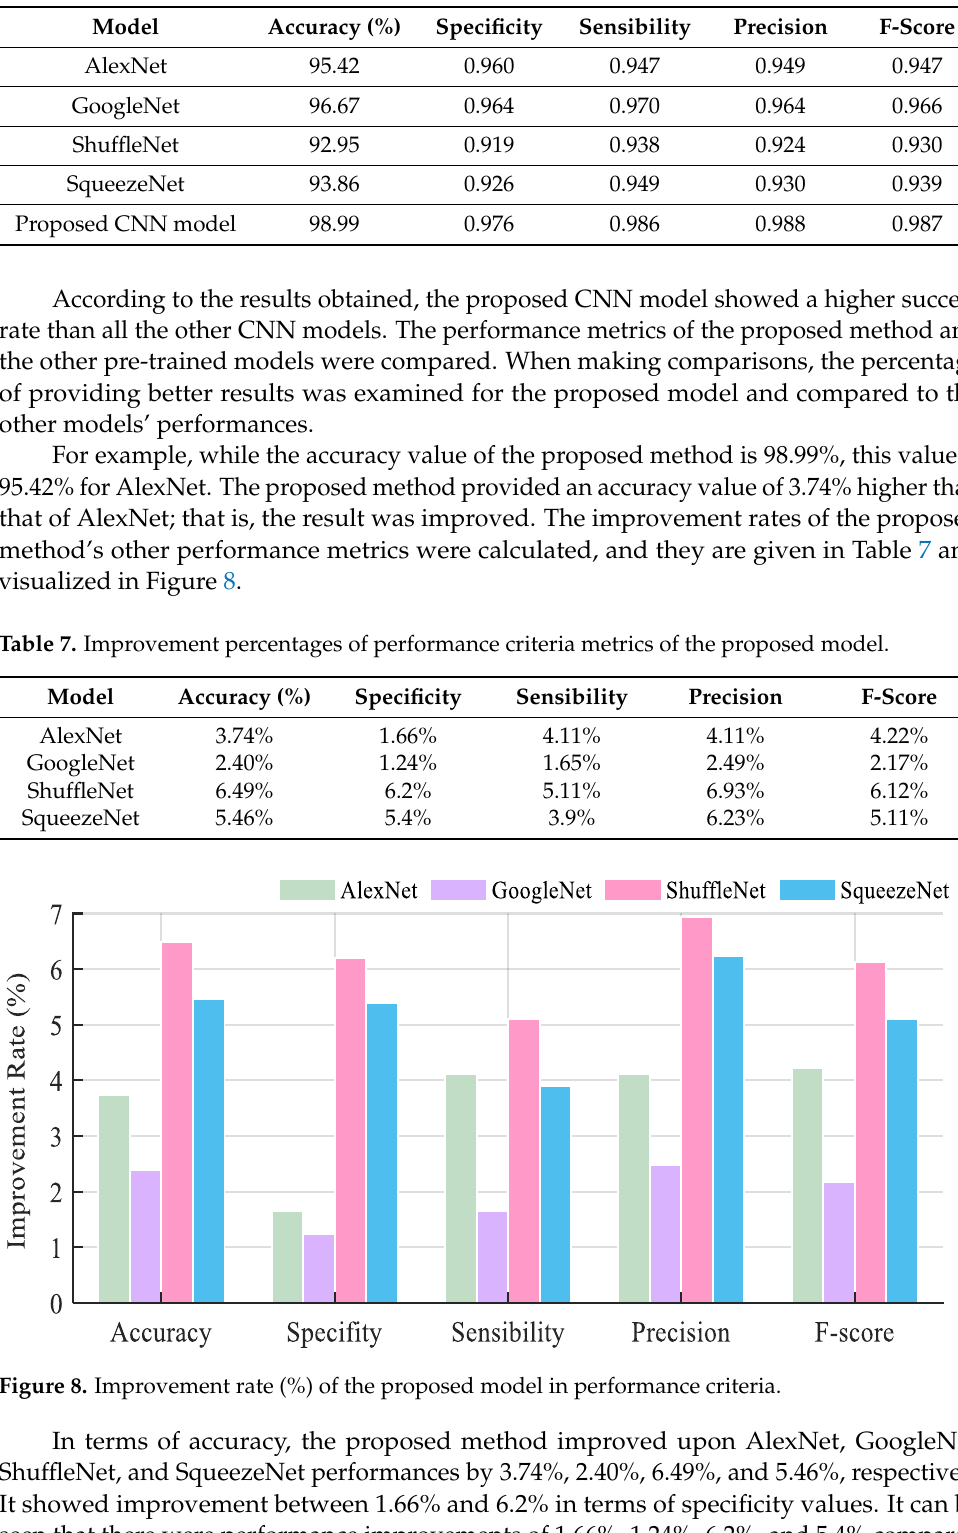
Table 6. CNN models’ performance results.